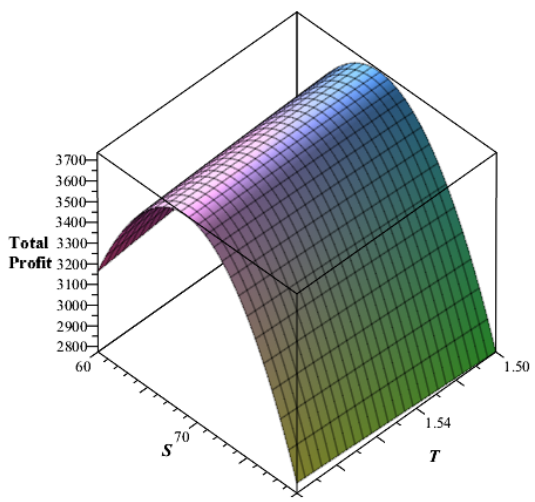
Figure 2. Optimality of a total profit function for situation 1 (0 < M < t n < T